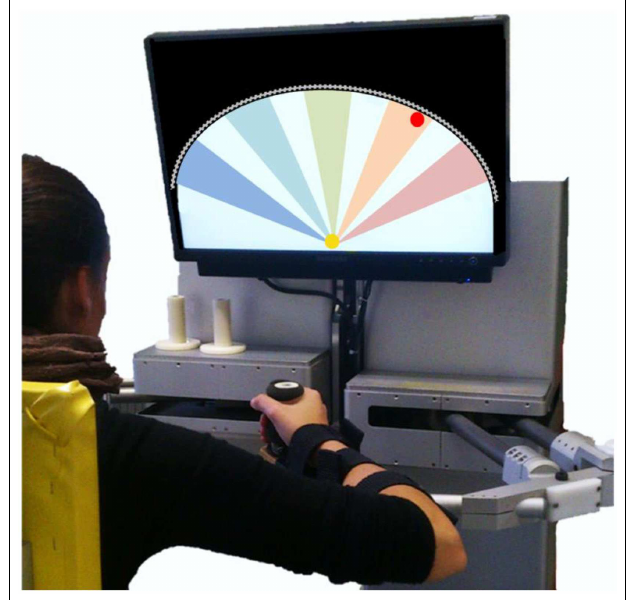
FIGURE 1 | Experimental setup .The screen located in front of the subject showed the actual hand position (yellow circle, ∅ 2cm) and the current target (red circle, ∅ 2cm).The workspace is limited by a virtual wall (gray line) that subjects cannot overstep.The five colored sectors on the screen represent the five main reaching directions: − 45°(blue), − 22.5°(light blue), 0°(green), 22.5°(orange), 45°(pink).